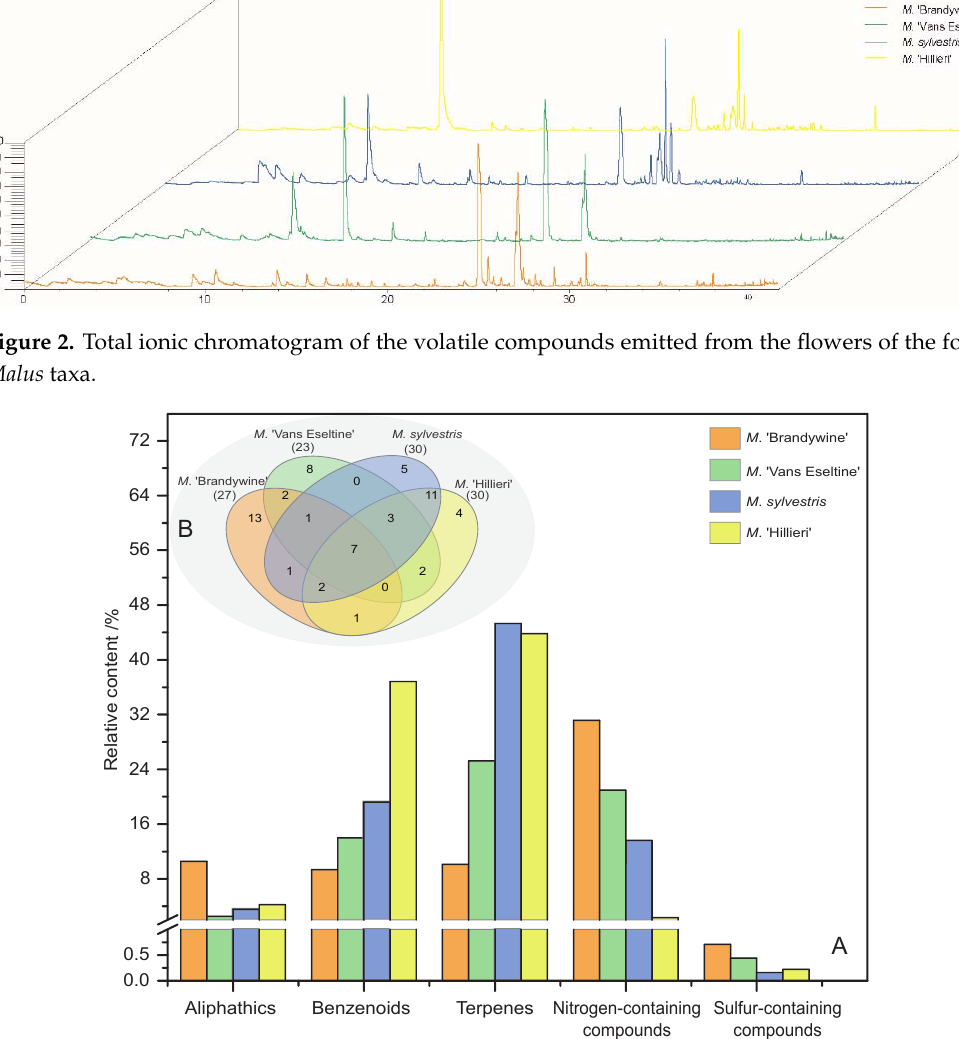
Figure 3. Statistical analysis of the volatile compounds present in the flowers of the four Malus taxa. ( A ) Compounds of different chemical classes among the four taxa. ( B ) Venn diagram indicating the similarities and differences in total volatile compounds among the different taxa. The numbers in related overlapping areas indicate the compounds shared between the different taxa.